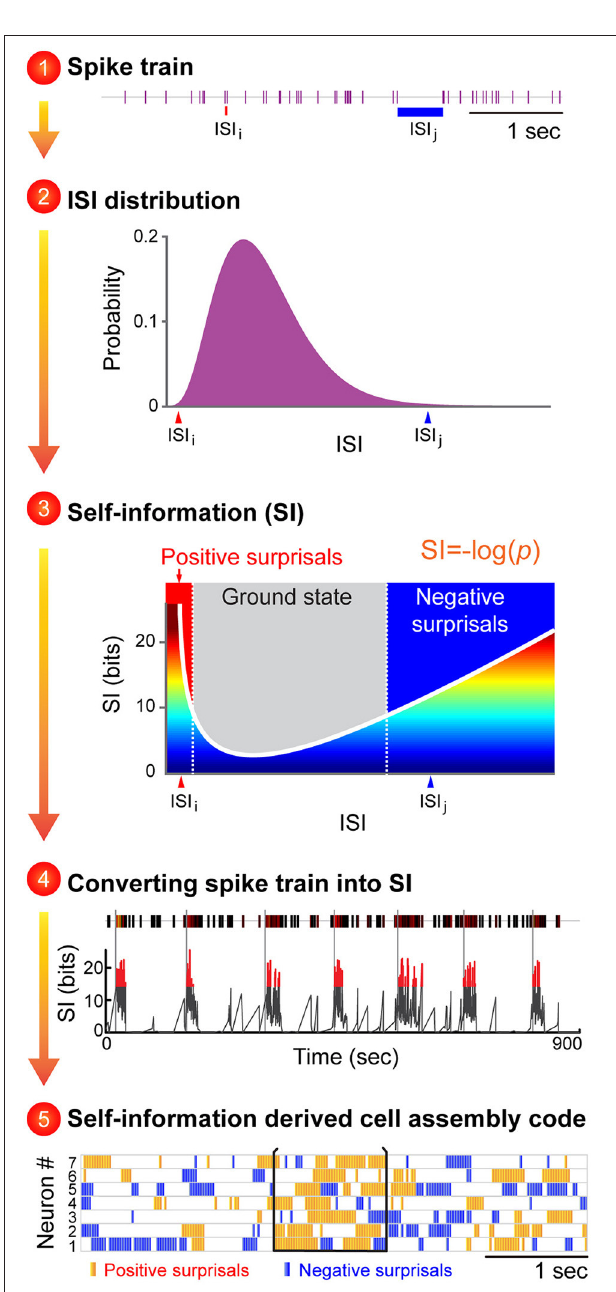
FIGURE 2 | An illustration to describe how the proposed Neural Self-Information Theory can be used to decode cell-assembly patterns from neuronal spike trains. The Self-Information Code is proposed to explain how real-time neural code is generated via spike-timing variability, and how cell-assembly patterns can be identified in an unbiased manner. A general strategy to apply the neural self-information theory to uncover cell assemblies from spike-train datasets. Cell-assembly code is identified in four steps based on the conversion of an individual neuron’s spike train into variability distribution of ISIs, followed by its conversion to a real-time self-information value. The temporally coordinated self-information surprisal patterns across cell population can be detected in an unbiased manner by pattern classification methods such as blind-source analyses. The unique feature of this self-information code is that this neural coding principle is completely intrinsic to the neurons themselves, with no need for any reference point to be set by outside